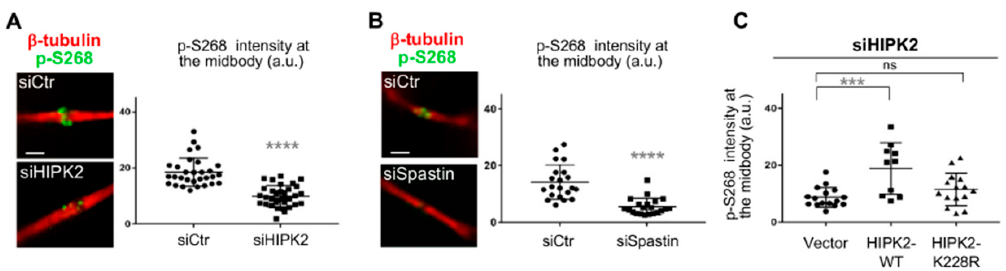
Figure 4. Analysis of spastin-S268 phosphorylation at the midbody. ( A ) Indicated HeLa cells were fixed and stained with DAPI, anti- β -tubulin, and p-S268 Abs, and analyzed to quantify the IF signal of p-S268 spastin at the midbody. Representative immunostainings of midbody magnification are shown. Bar, 1 μ M. Quantification in arbitrary units (a.u.) is reported in the dot plot showing the single measures, as well as, the mean value ± SEM from two different experiments **** p < 0.0001, Mann–Whitney test. ( B ) Indicated HeLa cells were stained and analyzed as in A. Representative immunostainings of midbody magnification are shown. Bar, 1 µM. Quantification is reported in the dot plot showing the single measures, as well as, the mean value ± SEM from three different experiments **** p < 0.0001, Mann–Whitney test. ( C ) Dot plot showing the quantification of the p-S268 spastin IF signal in indicated HeLa cells 24 h upon transfection with low doses of vectors expressing GFP-tagged murine HIPK2-WT or its kinase defective derivative. siHIPK2 cells were transfected with indicated vectors 48 h post siRNA transfection performed as in Figure 1A and analyzed 48 h post vector transfection by IF. Note that, in siHIPK2 cells, the expression of murine HIPK2 protein, showing >97% identity with human HIPK2 and fully recapitulating its functions, is not inhibited by RNAi because human-specific siRNAs were used. *** p < 0.001( p = 0.0005) t-test.